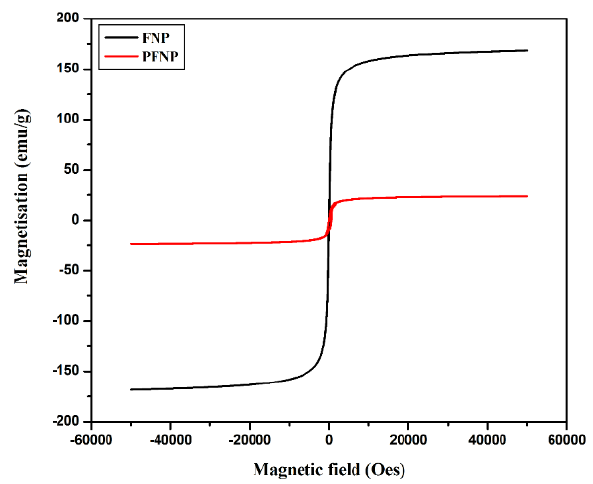
Figure 2. Hysteresis curve of the Pt–Fe 3 O 4 nanoparticles (PFNP) and Fe 3 O 4 nanoparticles (FNP).